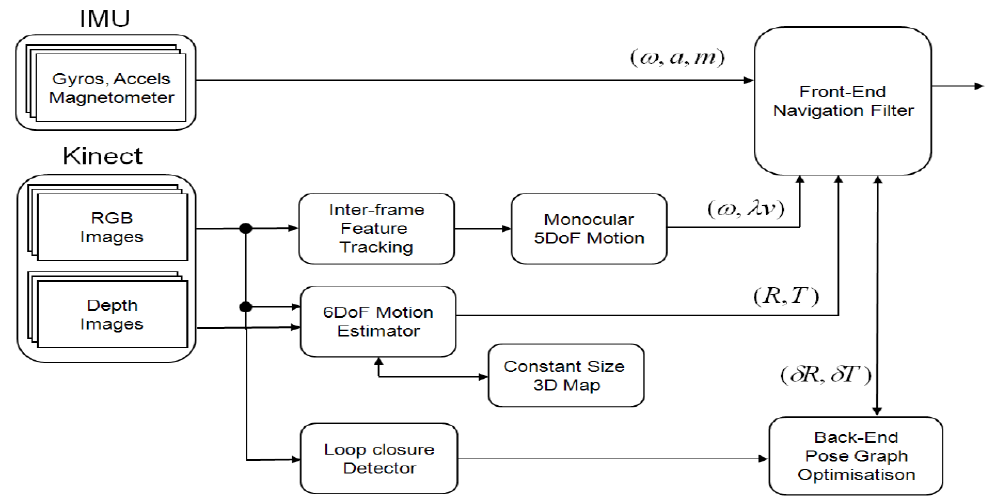
Figure 2. A loosely-coupled Inertial-Kinect odometry system architecture. RGB-D images are pro- cessed in a local Kinect odometry module that utilizes a window-based map for real-time processing. 2D RGB images are used for directional motion constraints and rotation rate and fused with inertial odometry within an extended Kalman filter. There is an off-board back-end SLAM that utilizes a keyframe-based graph SLAM to handle loop detection and